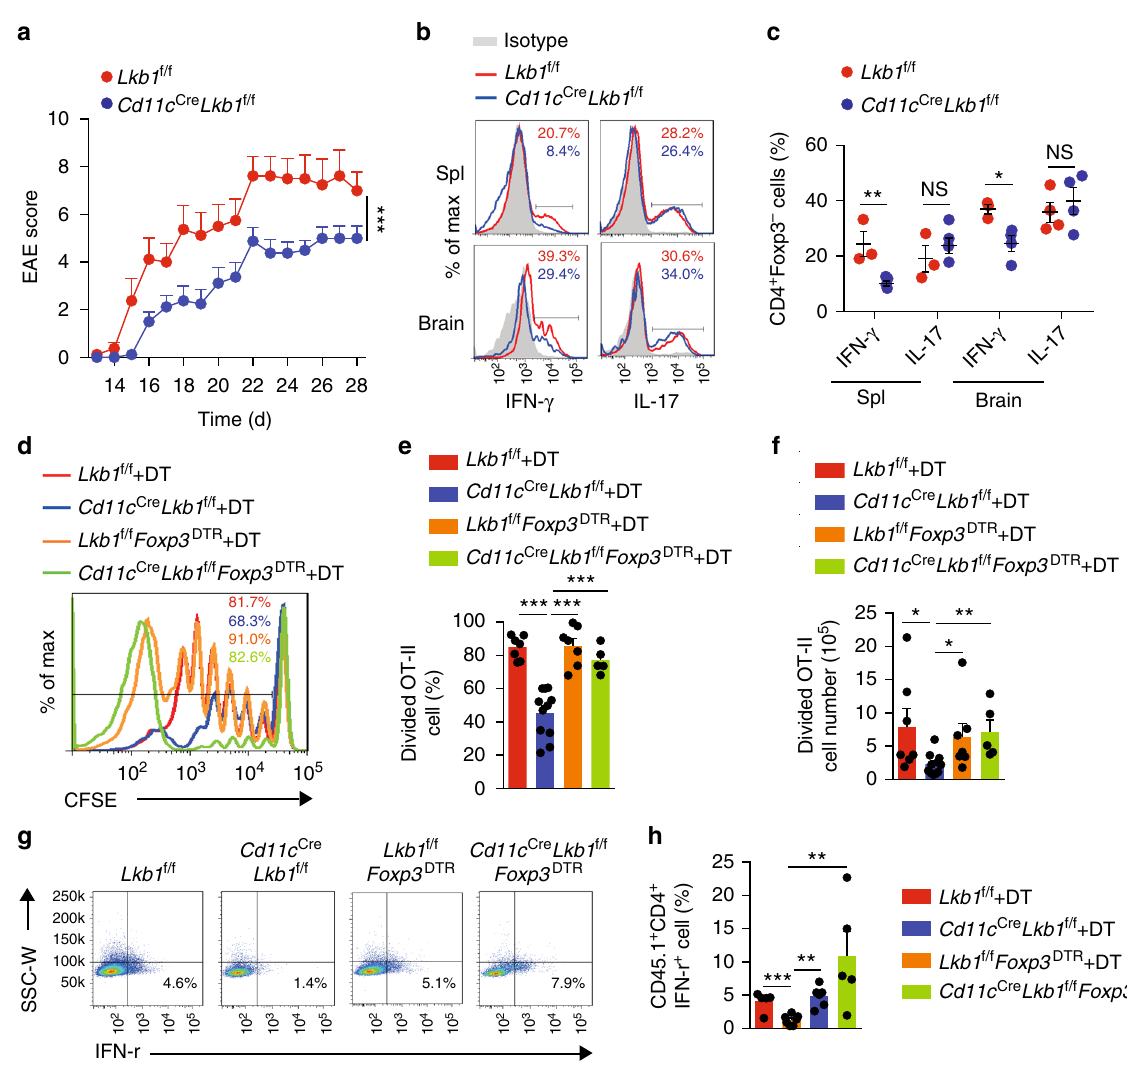
Fig. 2 Impaired adaptive immune responses due to increased T reg cell number. a Disease-related clinical scores of Lkb1 f/f and Cd11c Cre Lkb1 f/f mice subjected to MOG35 – 55-induced experimental autoimmune encephalomyelitis (EAE). b , c Flow cytometric analysis ( b ) and quanti fi cation ( c ) of IFN- γ - and IL-17- producing CD4 + Foxp3 − T cells in the spleen and brain of Lkb1 f/f and Cd11c Cre Lkb1 f/f mice with EAE. d – f Flow cytometric analysis ( d ), percentage ( e ) and absolute number ( f ) of CFSE-labelled CD4 + T cells (2×10 6 ) from OT-II mice transferred into Lkb1 f/f , Cd11c Cre Lkb1 f/f , Lkb1 f/f Foxp3 DTR and Cd11c Cre Lkb1 f/ f Foxp3 DTR mice treated with diphtheria toxin (DT) (50 μ gkg − 1 , 2 days in advance). g , h Flow cytometric analysis ( g ) and quanti fi cation ( h ) of IFN- γ - producing OT-II T cells in Lkb1 f/f , Cd11c Cre Lkb1 f/f , Lkb1 f/f Foxp3 DTR and Cd11c Cre Lkb1 f/f Foxp3 DTR mice stimulated with phorbol myristate acetate (PMA) and ionomycin for 4 h. The results are presented as the mean ± S.E.M., * P < 0.05, ** P < 0.01, by two-way ANOVA ( a ) or Student's t -test ( c , e , f , h ). Data are pooled from c , e , f, h or are representative of a , b , d , g three independent experiments with similar